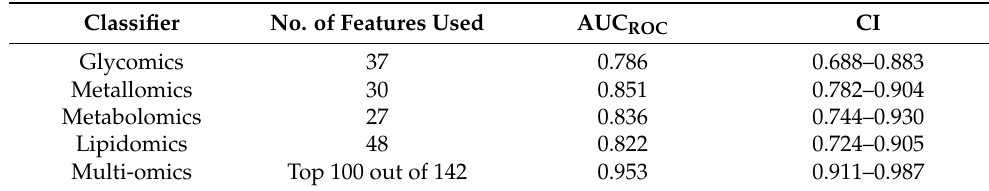
Table 4. Performance of random forest models built using glycomics, metallomics, metabolomics, lipidomics, and multi-omics features in classifying between AMI and